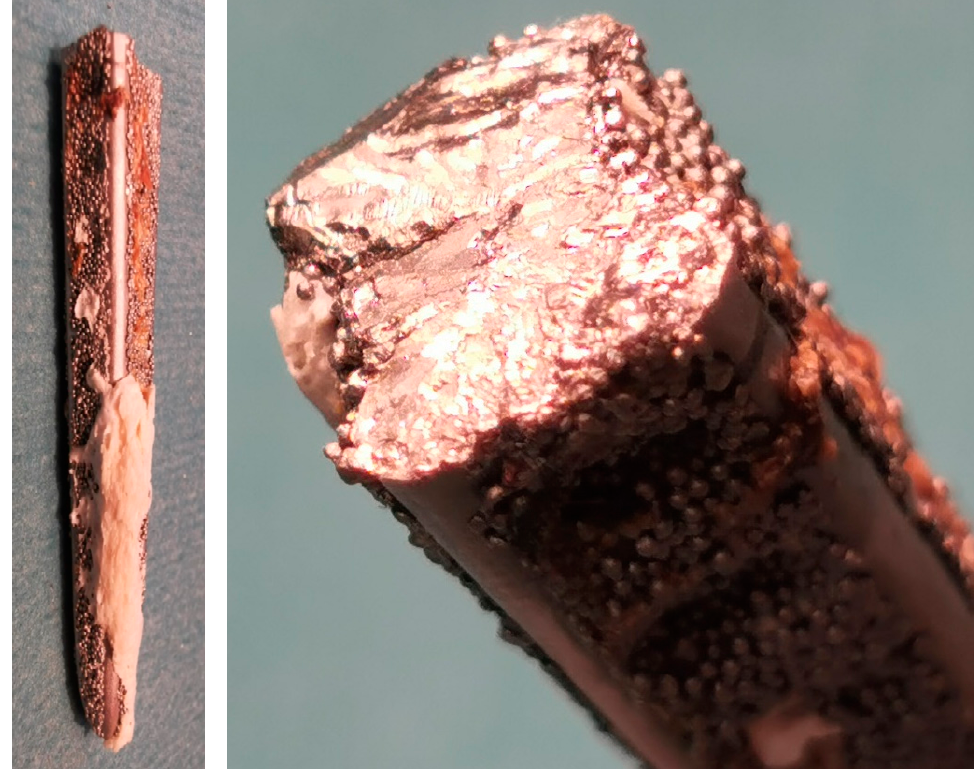
Figure 7. Broken stem of the hip prosthesis.